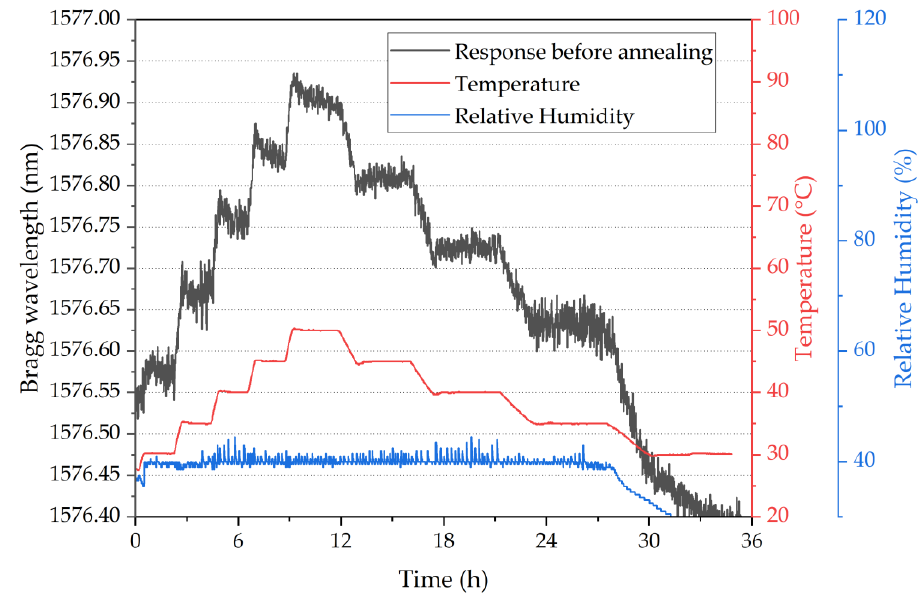
Figure 8. Temperature response of POFBG 4 during the first temperature characterisation.